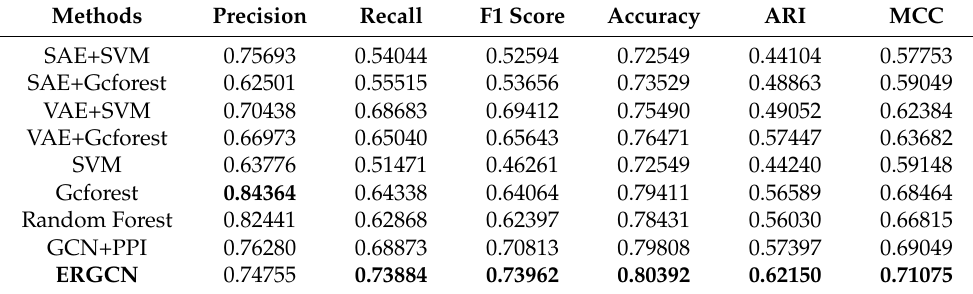
Table 5. The experiment results for a new sample on BRCA dataset.